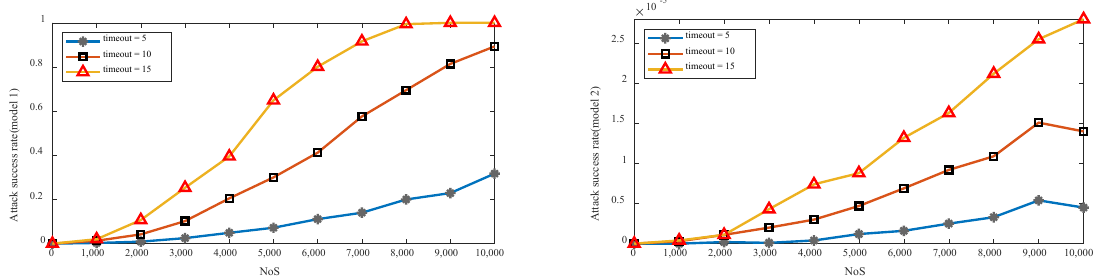
Figure 8. The relationship between the attack success rate of the two models and the number of forged messages of the attacker unit, ( a ) traditional VPN model, ( b ) MVPN model.